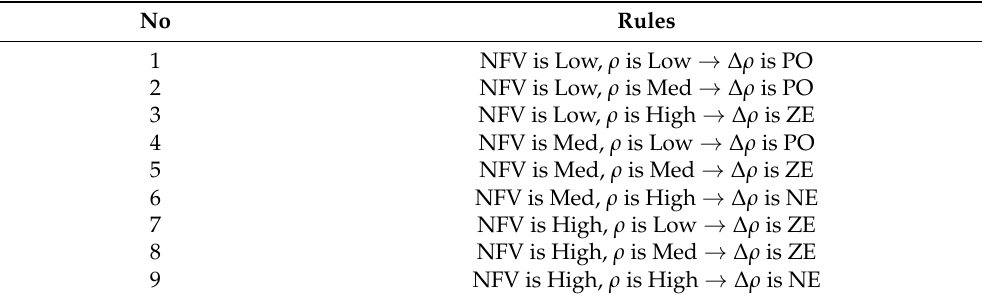
Table 6. Fuzzy logic rules.